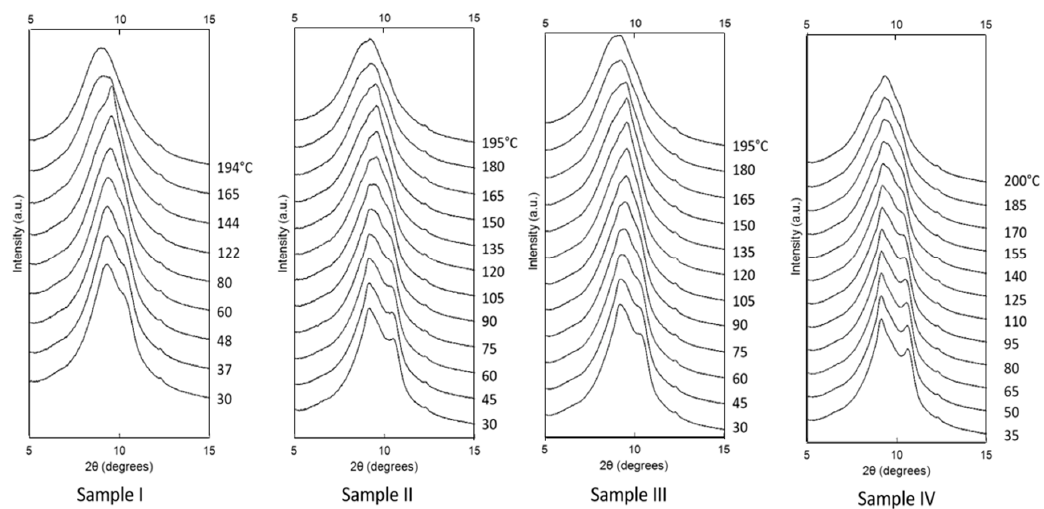
Figure 7. One-dimensional WAXS patterns (shifted vertically for clarity) for the four samples as a function of temperature during cooling. The small peak at 2 θ = 12.5 °C is due to background diffraction.